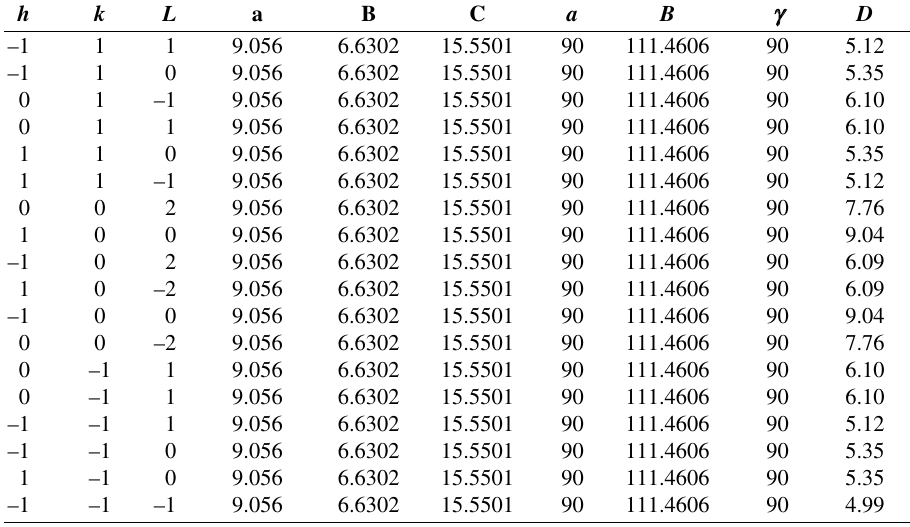
Table 5: List of the predicted miller indices of Str 1 with interplanar d